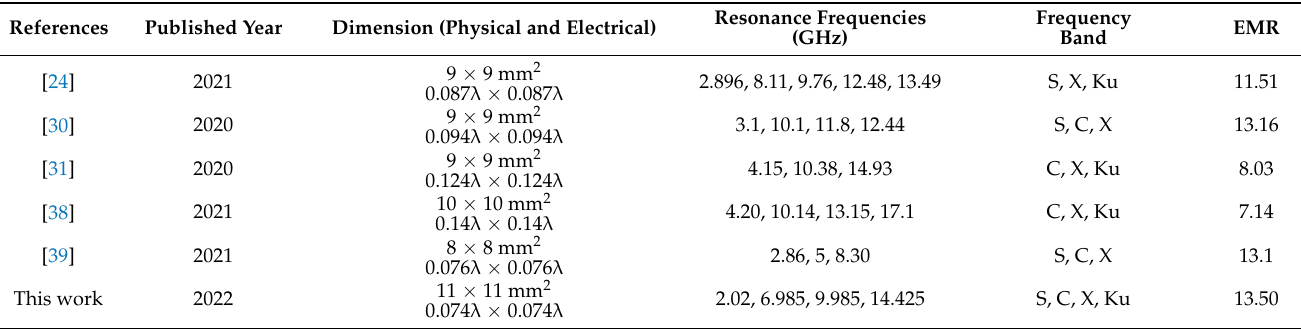
Table 2. Comparison with recent published metamaterial